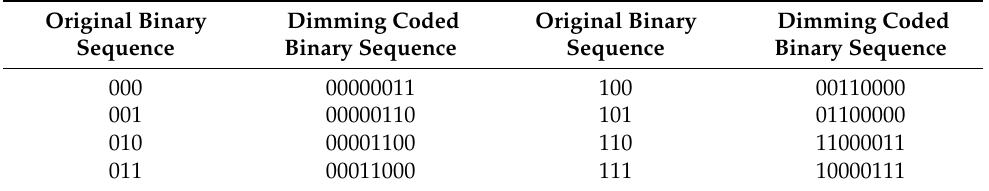
Table 2. The mapping between the original binary sequence and the dimming coded binary sequence with k = 3, n = 8, and γ = 5/16.